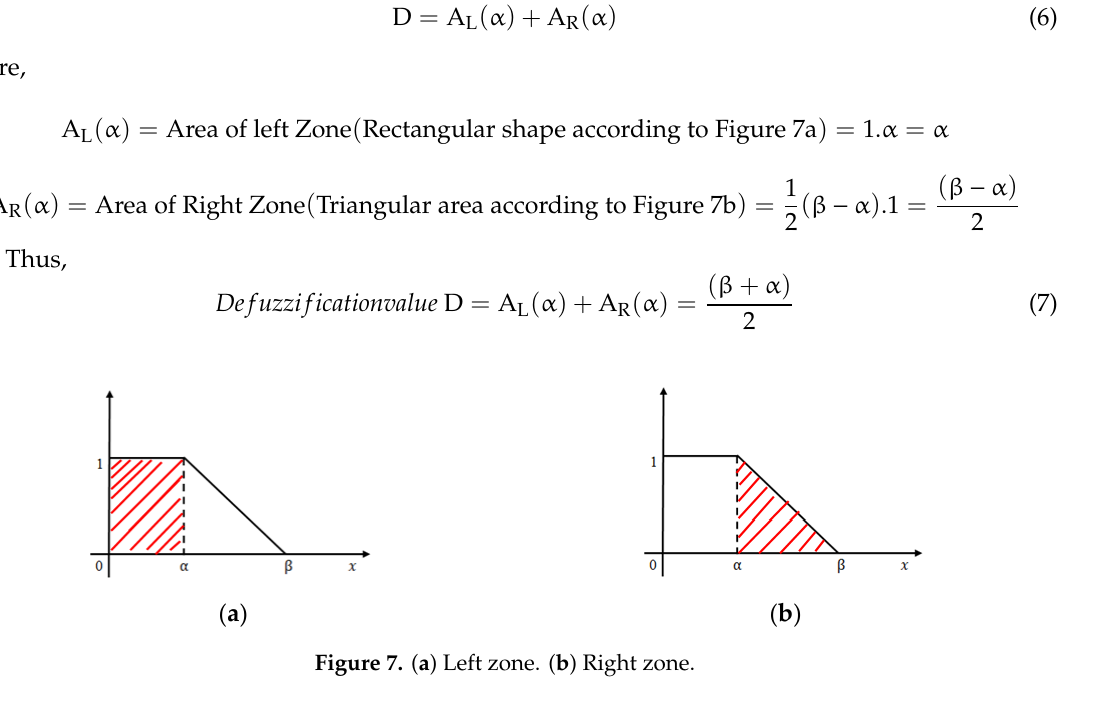
( d ) Figure 8. Sequential output of the two phase iteration segmented process. ( a ) Segmented lesion area of iteration I, ( b ) segmented output of iteration I, ( c ) segmented lesion area of iteration II, ( d ) final output of iteration II . 4.4. Feature Extraction Since early detection of lesion is a crucial step in the field of skin cancer treatment, right feature extraction can be a vital tool for exploration and analysis of the image. Dermoscopy plays a vital role in examination and inspection of superficial skin lesions significantly improving the sensitivity and specificity of experts for diagnosis of melanoma. A widely accepted rule for feature extraction is the ABCD rule of clinical diagnosis [46,47]. It defines the basis for diagnosis of disease and is a rather safe method as it can be easily detected visually without performing any penetration in the body. This rule fittingly addresses the fundamental question in dermoscopy of whether a melanocytic skin lesion is benign, suspicious (borderline) or malignant. The rule was first introduced in 1985 as the ABCD rule by Stolz and then expanded in 2004 to the ABCDE rule, encompassing several clinical features of melanoma, including Asymmetry, Border irregularity, Color variation, Diameter greater than